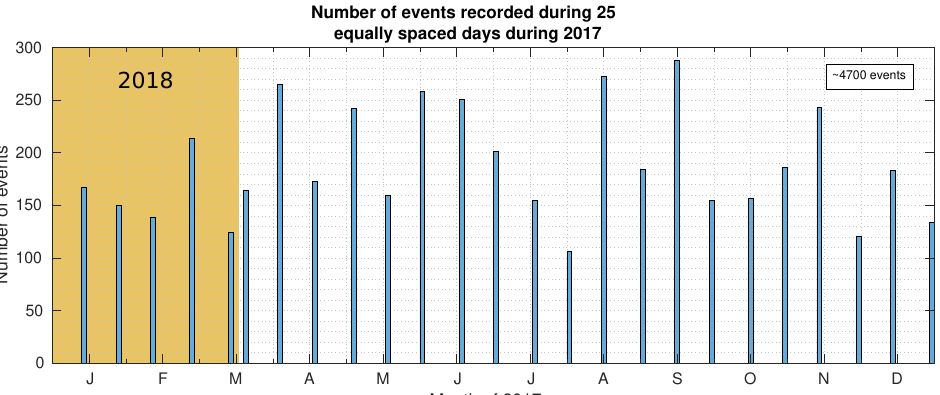
Figure 15. Histogram of events recorded during 25 equally during the first year of operation of CYGNSS, starting in March 2017, and ending in March 2018. Note that bars over the orange background belongs to 2018. The height of each peak represents the number of events recorded this day. The total number of counts is around